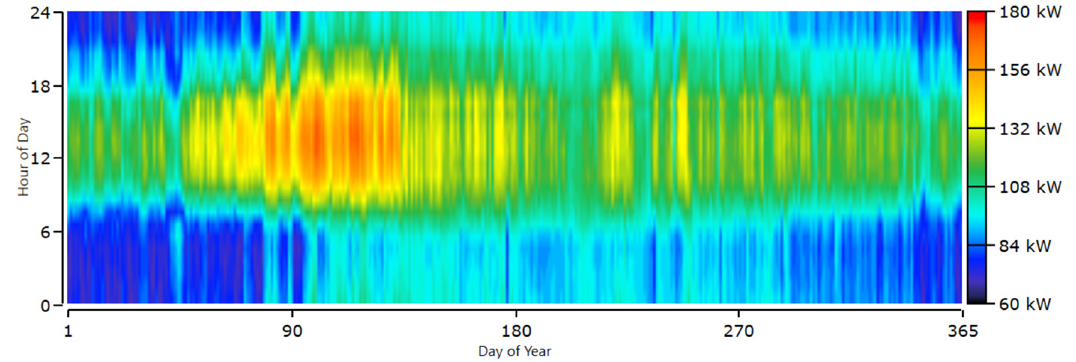
Figure 6. Detailed annual electrical load profile for a site near Clark Air Base, Philippines.